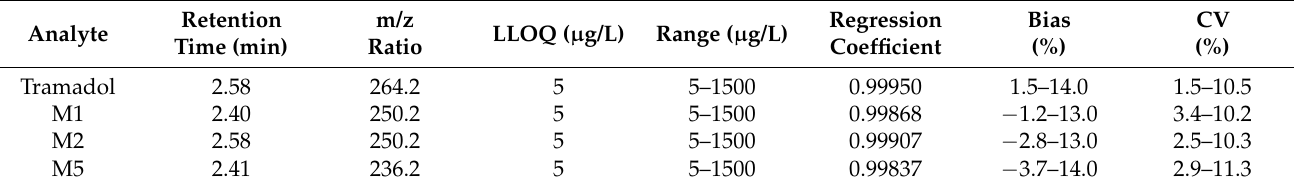
Table 1. Summary of the validation information of the analysis of tramadol and the